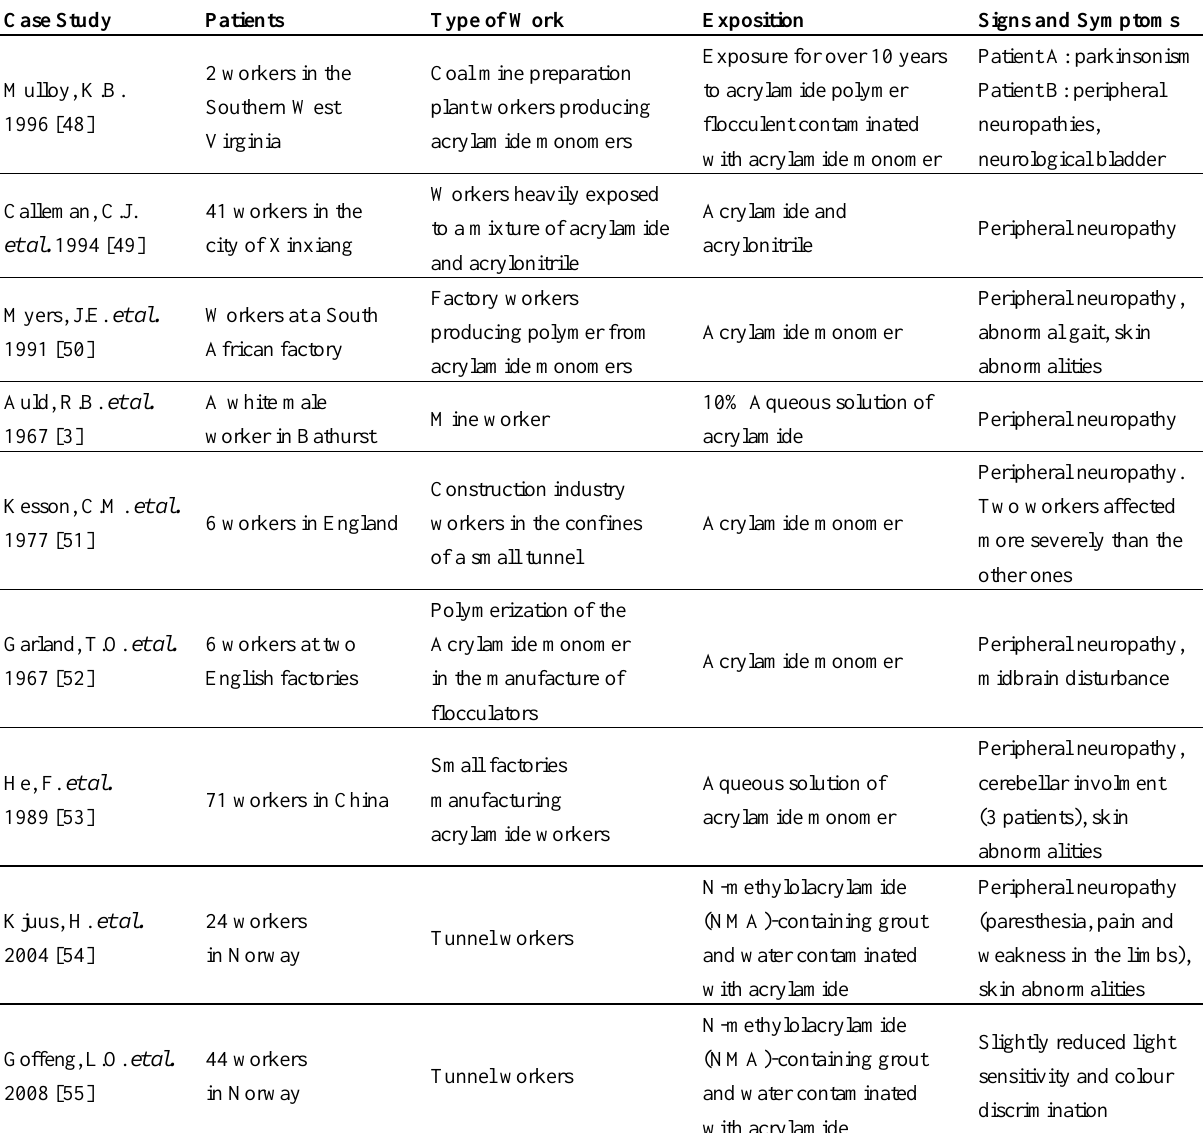
Table 1. Acrylamide neurotoxicity case studies in